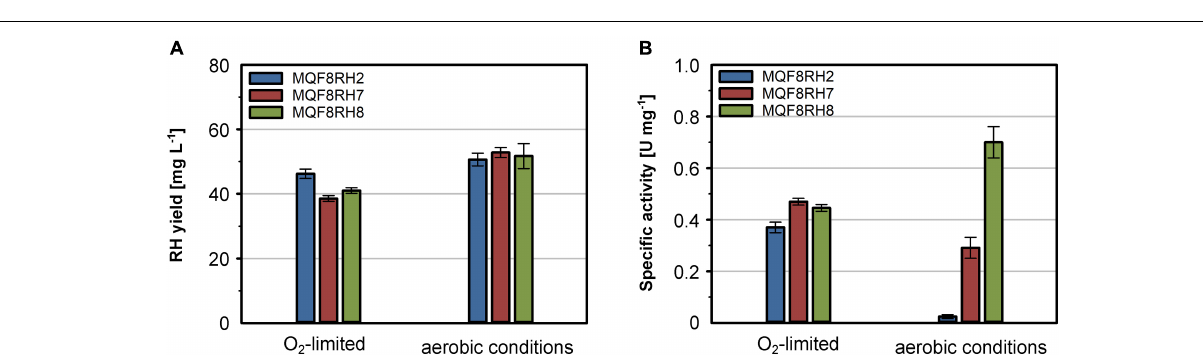
FIGURE 6 | Effect of hoxN1 and hypX genes on the production of active RH. E. coli strains MQF8RH2 (RH-Hyp1), MQF8RH7 (RH-Hyp1-HoxN1) and MQF8RH8 (RH-Hyp1-HoxN1-HypX) were cultivated at 18 ◦ C in 50 mL boosted EnPresso B medium supplemented with 0.1 mM NiCl 2 . After induction with 50 µ M IPTG, RH production lasted for 48 h under either aerobic or O 2 -limited conditions. (A) RH protein was purified by affinity chromatography, and the yield was quantified. (B) Specific activities measured from the purified RH